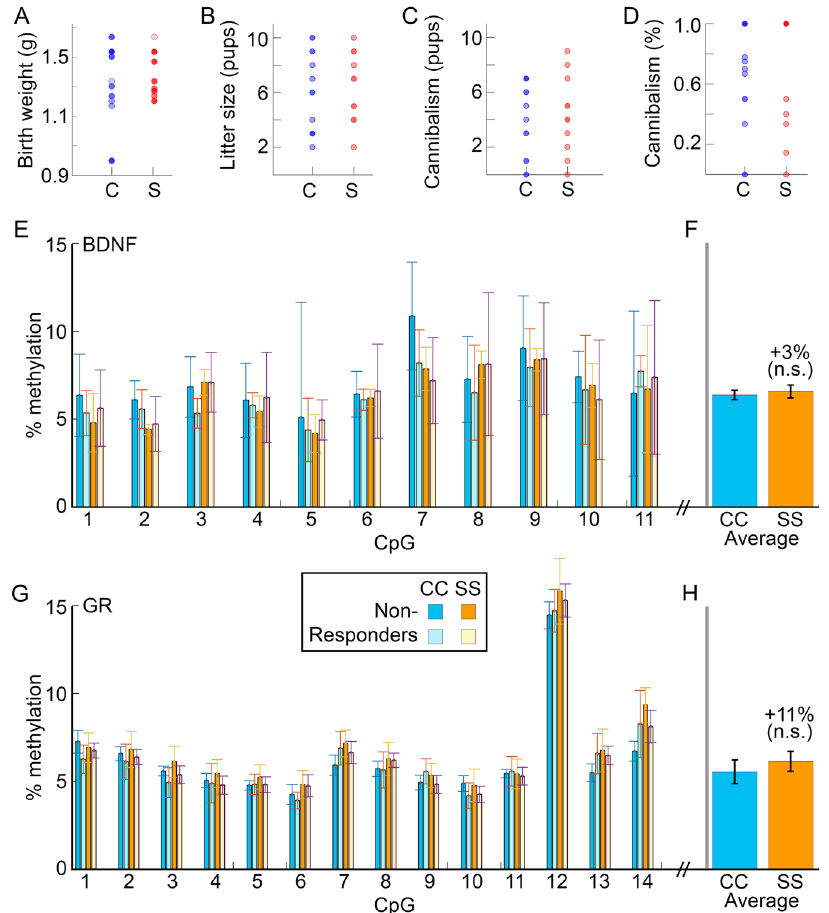
Figure 6. DCCD does not lead to differential methylation patterns of the GR and BDNF genes. Birthweight for S and C litters do not differ ( A ). Litter size ( B ), number of pups cannibalized by the mother ( C ), or percent of litters cannibalized ( D ) are not affected by circadian disruption. Hypermethylation of BDNF V ( E ) and GR 1 7 ( G ) regulatory regions of the genome is also absent in SS offspring. High and low responders were chosen from each group, and no apparent effect of phenotype on methylation